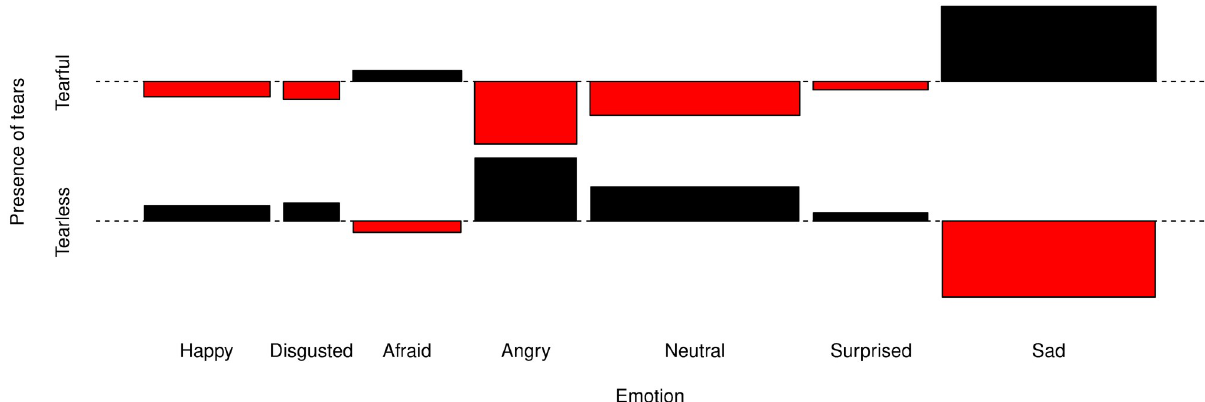
ffiffiffiffi p ¼ f (cid:0) e = , e ij ij ij ij